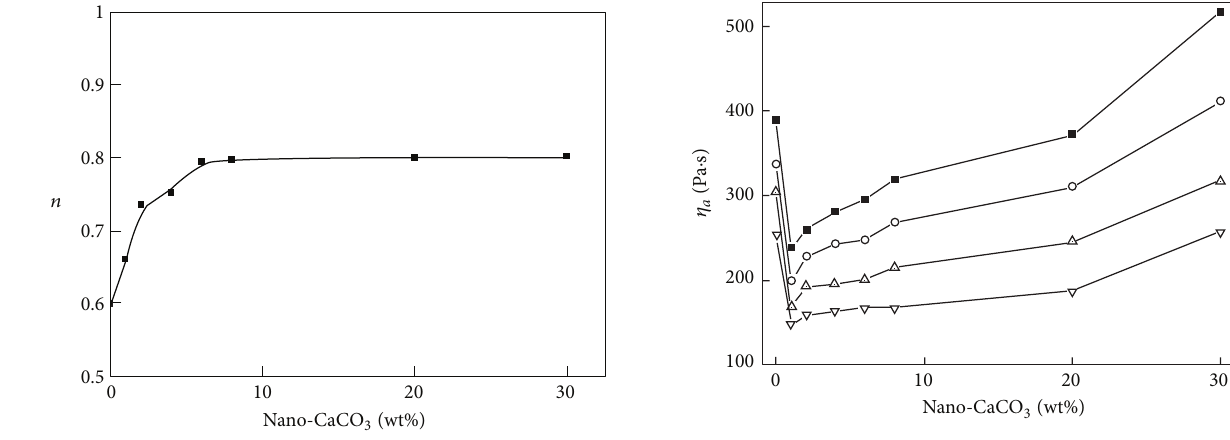
Figure 3: Relationship between 𝑛 and CaCO 3 wt% in nanocompos- ites.